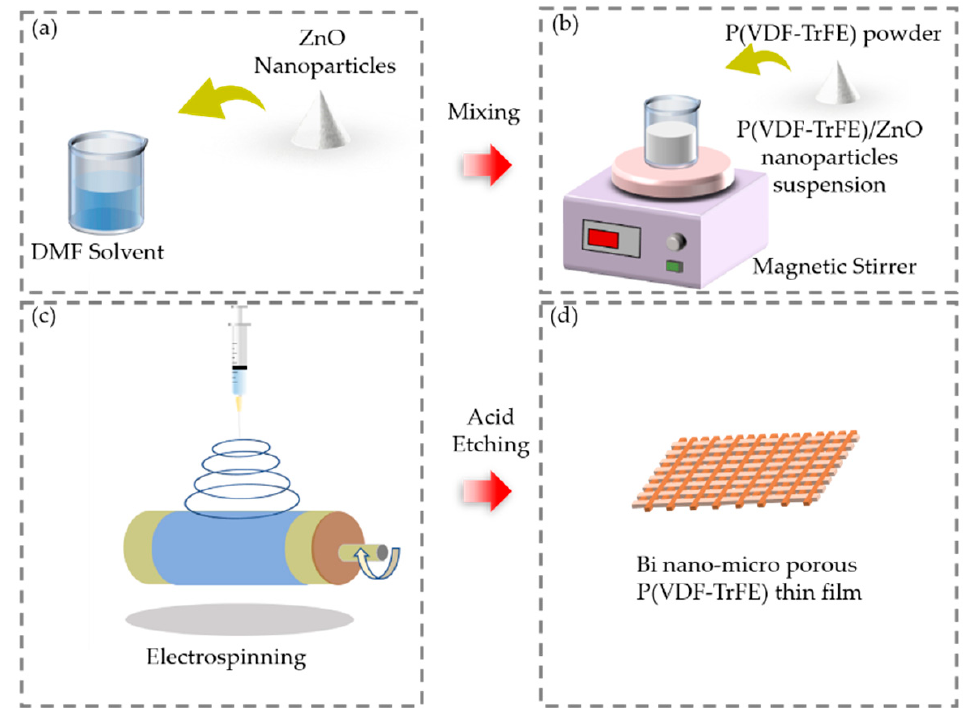
Figure 1. Schematic of the process for producing the pressure-responsive film by electrospinning and acid solution etching. ( a ) Mixing the ZnO nanoparticles; ( b ) dissolving the P(VDF-TrFE) powder. ( c ) Conceptual structure of electrospinning. ( d ) Responsive film after acid etching.